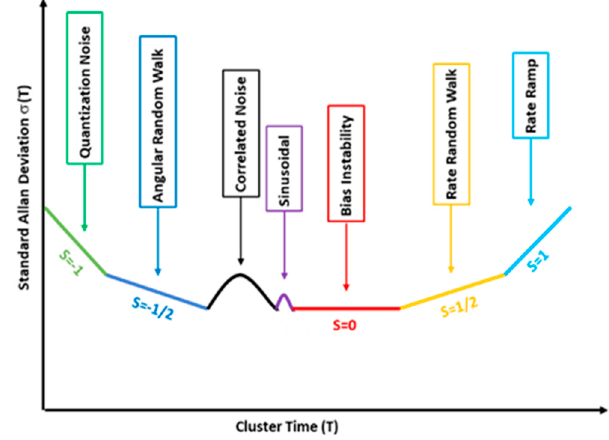
Figure 1. Allan deviation: characteristics parameter [16].